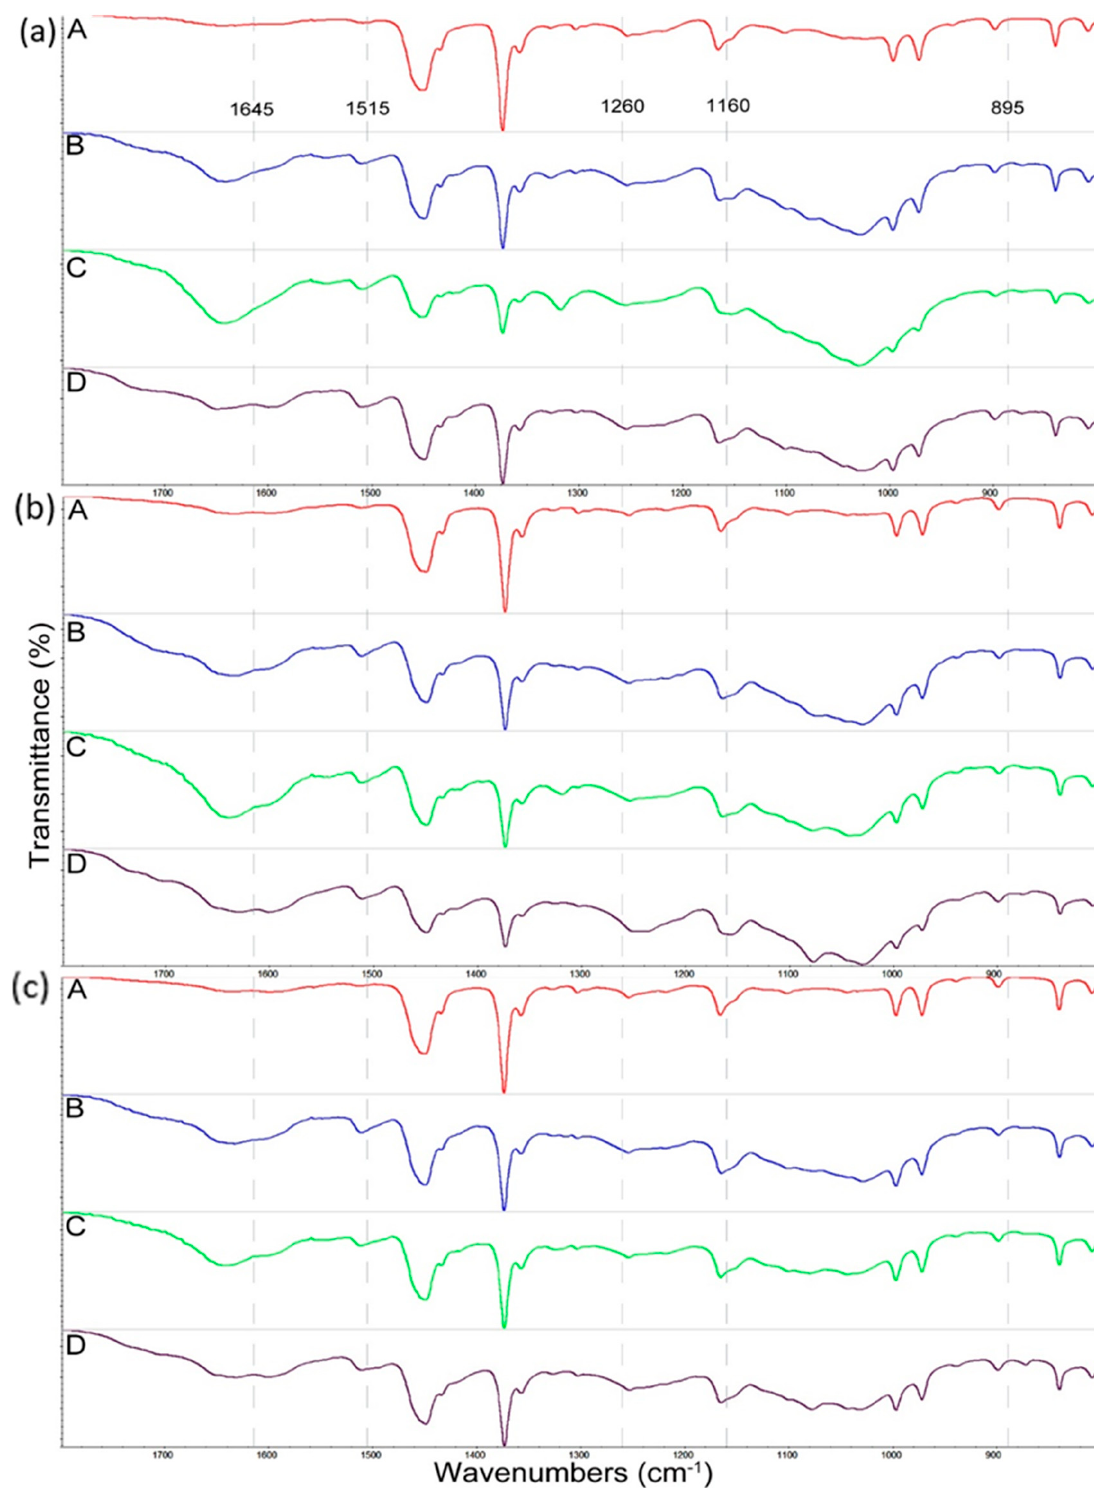
Figure 6. FTIR–ATR spectra of composite samples: ( a ) PP+W (A–), ( b ) PP+W+EEP (A–), and ( c ) PP+W+EEP+silanes (A–), after UV aging (30 days) and exposure to C. puteana (B–), C. versicolor (C– ), and Ch. globosum (D–).